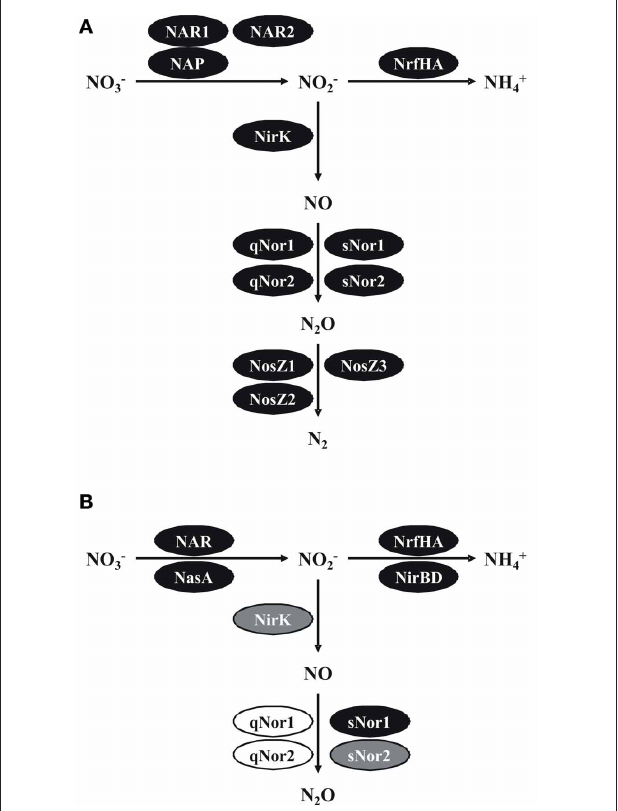
FIGURE 4 | Pathways and functional gene inventories for denitrification and ammonification in B. azotoformans LMG 9581 T (A) and B. bataviensis LMG 21833 T (B). Black ovals indicate predicted functional enzymes, gray ovals likely functional enzymes and white ovals pseudogenesor corrupted enzymes. NAR, cytoplasmic dissimilatory nitrate reductase; NAP, periplasmic dissimilatory nitrate reductase; NasC, assimilatory nitrate reductase; NrfHA, dissimilatory nitrite reductase to ammonium; NirBD, assimilatory nitrite reductase; NirK, periplasmic nitrite reductase to nitric oxide; qNor, dissimilatory quinol-dependentnitric oxide reductase; sNor, dissimilatory menaquinol/cyt c -dependent nitric oxide reductase; NosZ, dissimilatory nitrous oxide reductase. See text for more